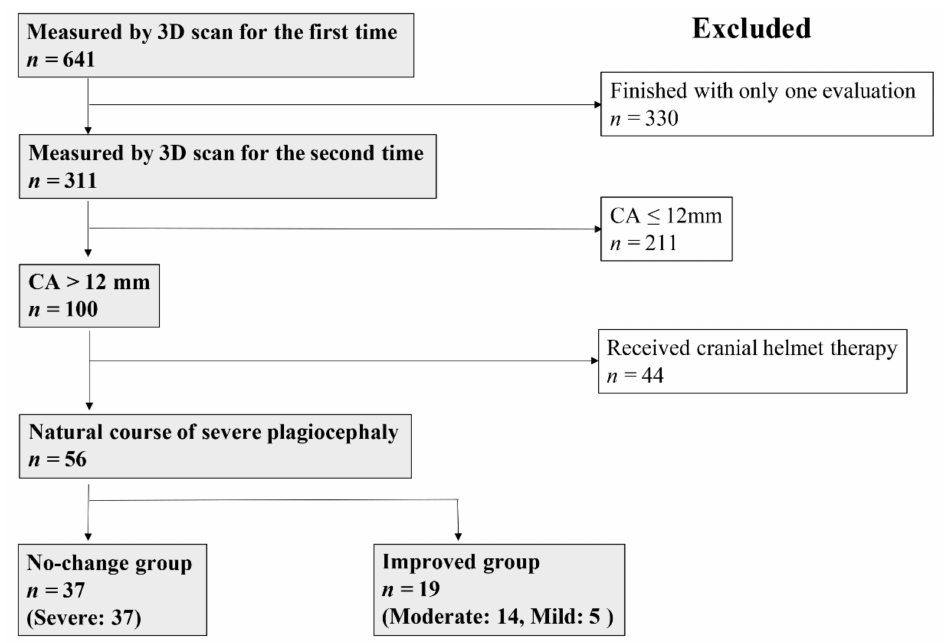
Figure 1. Flowchart of the enrolled infants with severe plagiocephaly following the natural course for Study 1. CA, cranial asymmetry; 3D, three-dimensional.